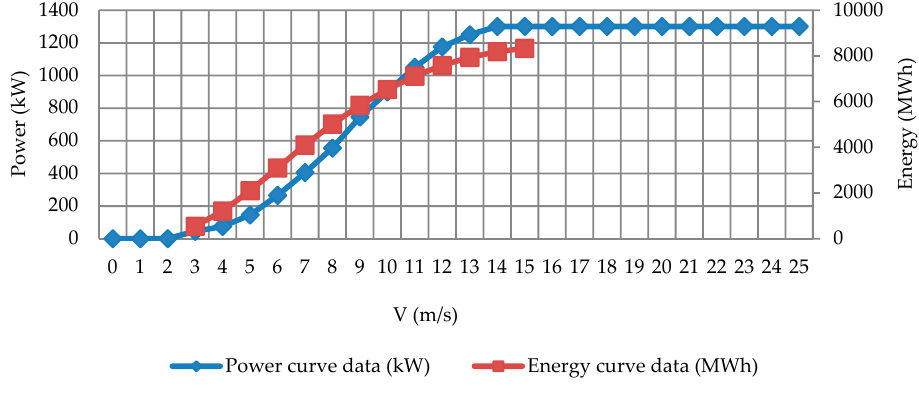
Figure 10. Wind turbine power and energy curve.